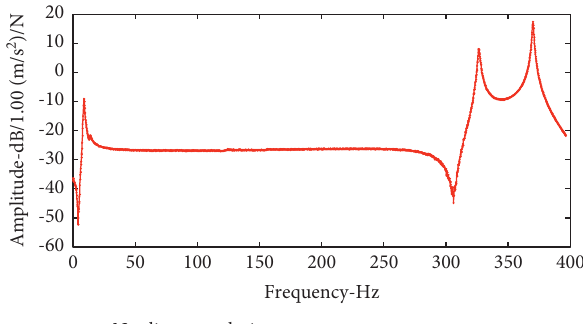
Figure 7: Frequency response function (FRF) of tip accelerometer for two elastic vibration modes (random excitation force 10.8N).